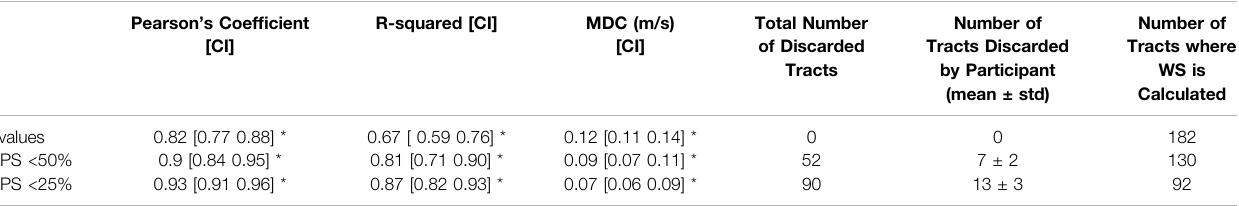
TABLE 3 | Summary results.